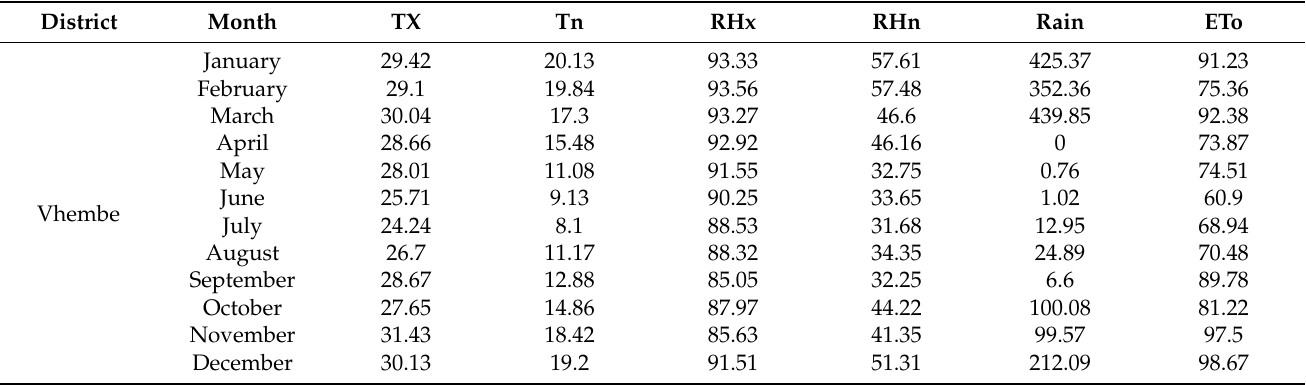
Figure 1. Map indicating the Capricorn and Vhembe districts. Table 1. Long-term (2010–2020) weather information of the Vhembe and Capricorn